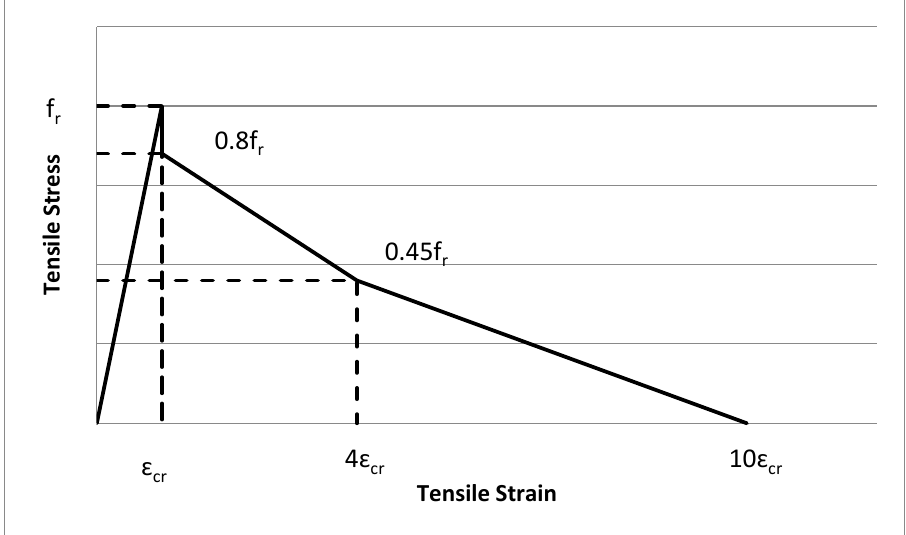
Figure 1. Nayal and Rasheed (2006) proposed concrete tension stiffening model. (f r is the concrete tensile strength and ε cr is the concrete cracking strain).